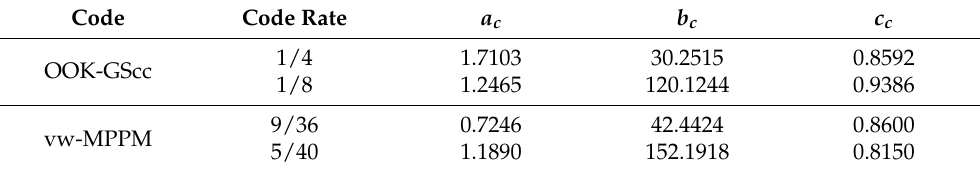
Table 1. Hyper-exponential fitting parameters a c , b c and c c in the absence of turbulence.